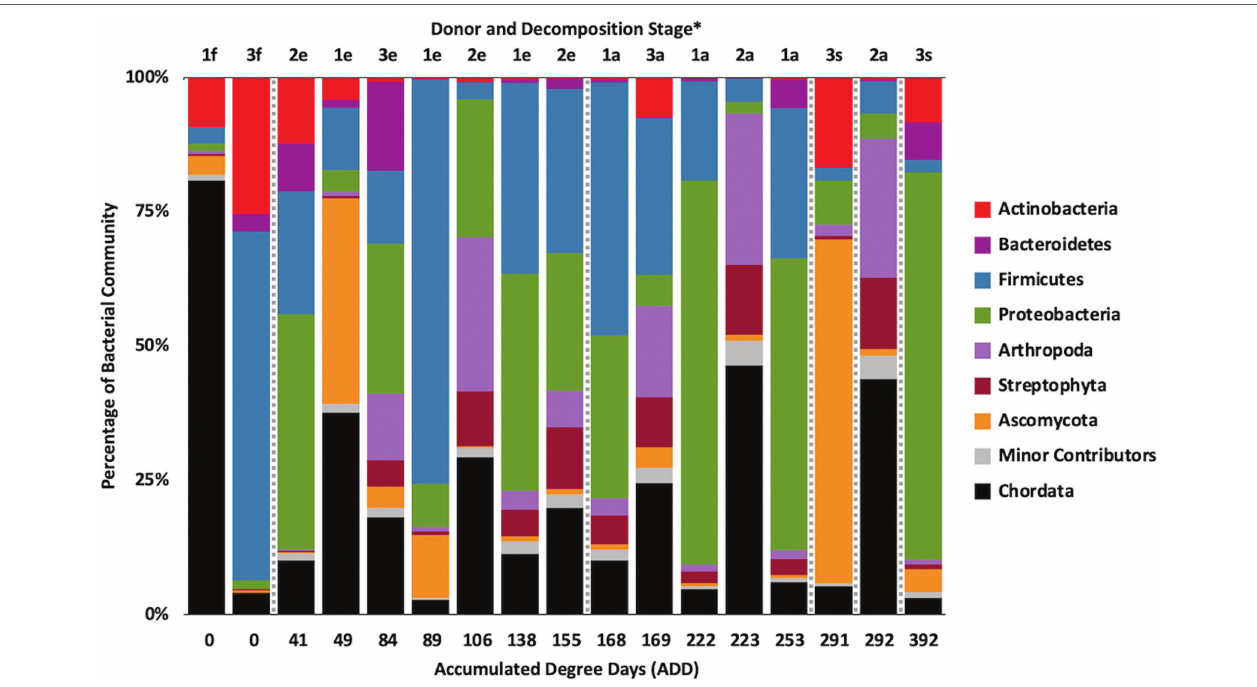
FIGURE 6 | Proportions in percentages of bacterial and eukaryotic phyla determined from shotgun metagenomic (MetaG) sequencing from oral samples of three human donors (Donors 1, 2, and 3) during decomposition. Decomposition was assessed as ADD on the x -axis and samples were also classified to an overall decomposition stage for each donor at each sampling event ( * f , fresh; e , early; a , advanced; and s , skeletonized). Minor contributors include data that accounted for <1% of the total diversity within a